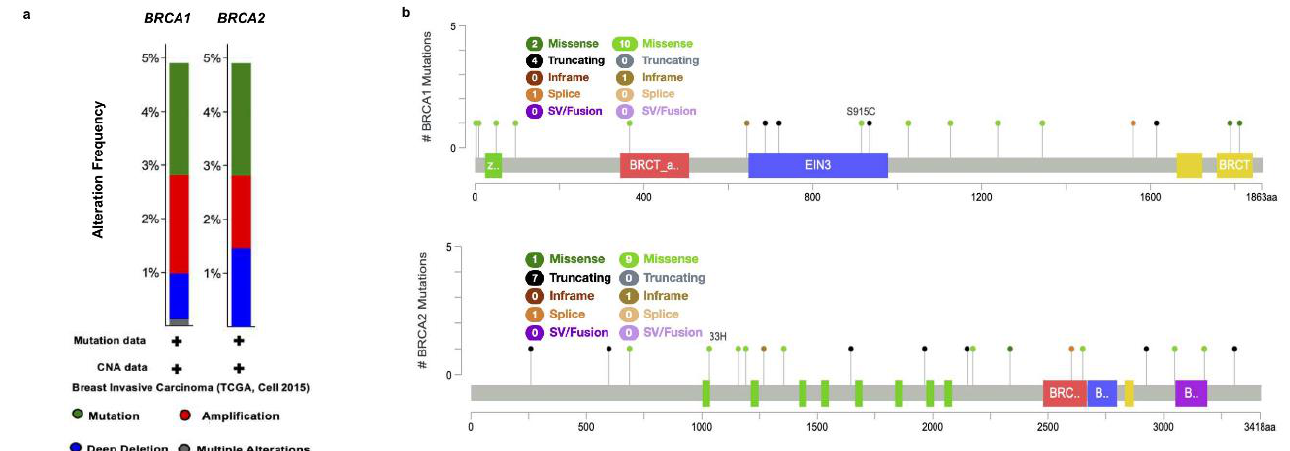
Figure 5. BRCA1/2 alteration frequency of mutations and copy number alterations (CNAs) in Breast Cancer (cBioPortal web). ( a ) The alteration frequency of the BRCA1/2 signature was determined cBioPortal (http://www.cbioportal.org, accessed on 10 February 2022). The alteration frequency included mutations (green), amplifications (red), deep deletions (blue), and multiple alterations (grey). ( b ) Summary of mutations in BRCA1/2 in BRCA from TCGA, cell 2015.